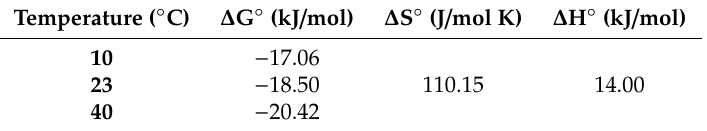
Table 5. Thermodynamic parameters of Zinc (Zn) sorption on the biomass-based activated